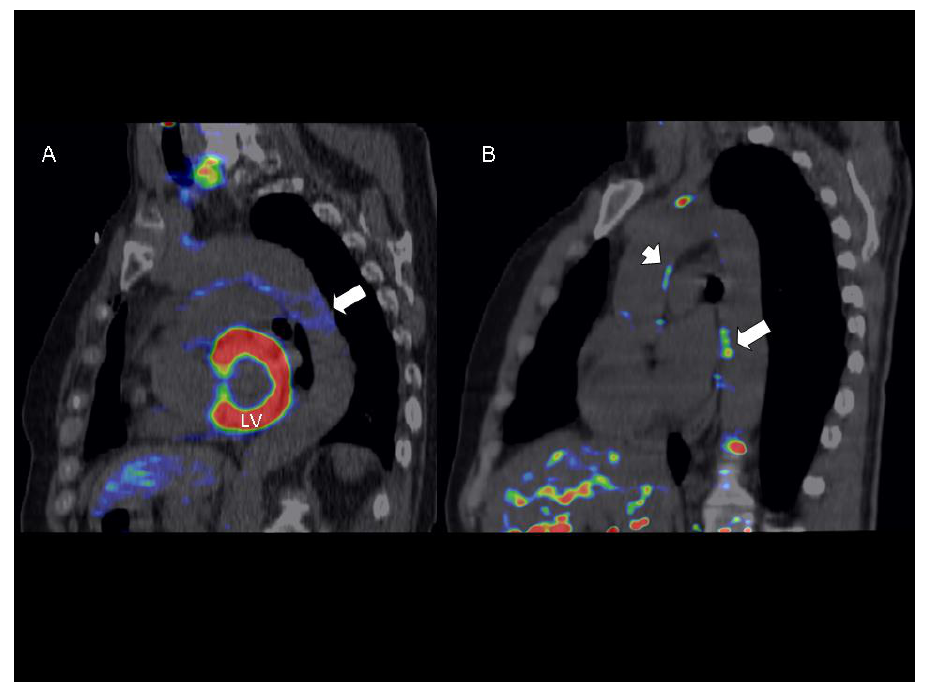
Figure 2. Representative 18 F-FDG-PET/CT image of thoracic aorta. ( A ) 18 F-FDG-PET/CT image from a patient in the high cystatin C group (cystatin C = 1.38 mg/mL) showing a non-significant focus ( arrow ) of 18 F-FDG uptake in the descending aortic wall with a TBR max of 1.3 ( 18 F-FDG-PET slices are defined as active if TBR max is ≥ 1.6) ( B ) 18 F-FDG-PET/CT image from a patient in the low cystatin C group (cystatin C = 0.84 mg/mL) showing an active focus of 18 F-FDG uptake in the descending aorta with a TBR max of 2.0 ( arrow ) and a non-active focal 18 F-FDG uptake ( arrowhead ; TBR max = 1.5) in the ascending aorta. Abbreviations: 18 F-FDG-PET/CT = 18 F-fluorodeoxyglucose-positron emission tomography/computed tomography; LV = left ventricle; TBR = target to background